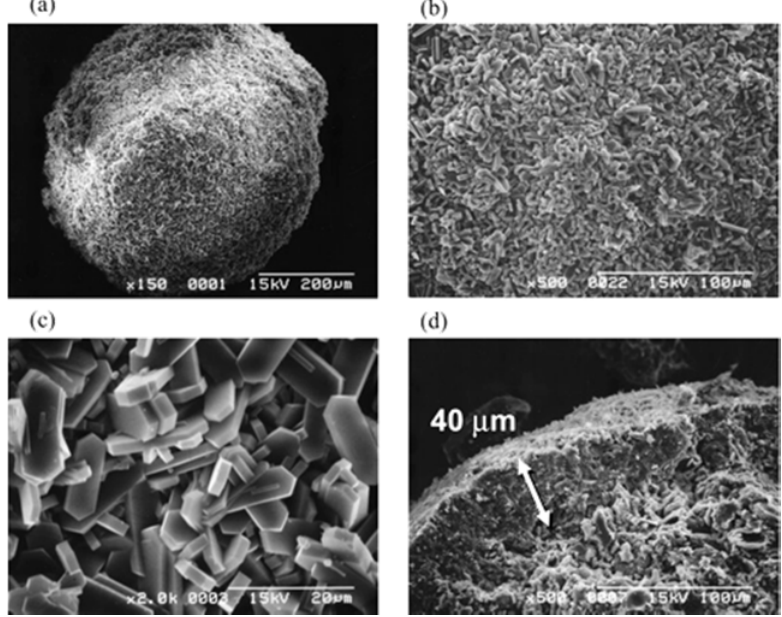
Figure 10. SEM images of Pt/TiO 2 particles coated with silicalite-1. Reprinted with permission from [249]. Copyright (2004) American Chemical